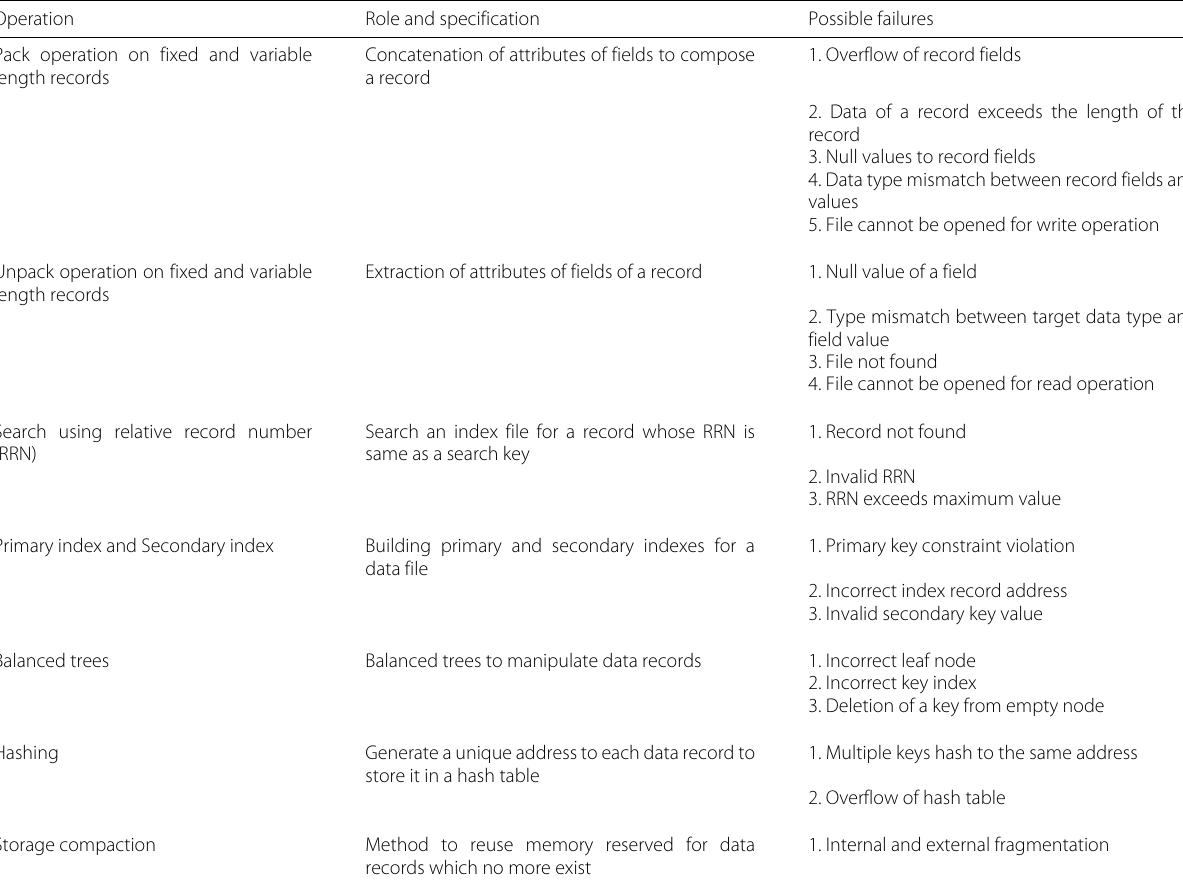
Table 3 Possible failures in each operation Operation Role and